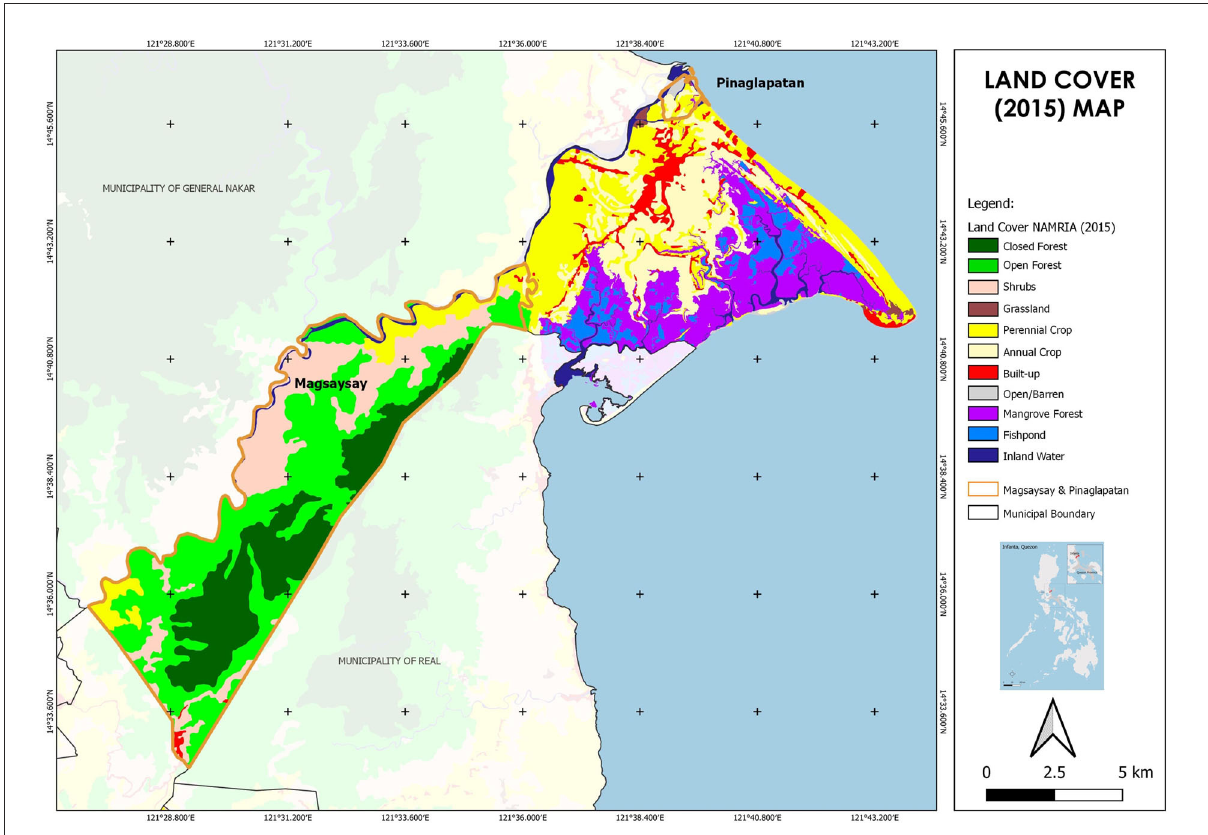
FIGURE3 Land cover map of Infanta in 2015. Source: Data from National Mapping and Resource Information Authority